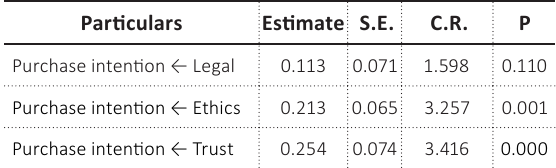
Table 4. Hypotheses testing